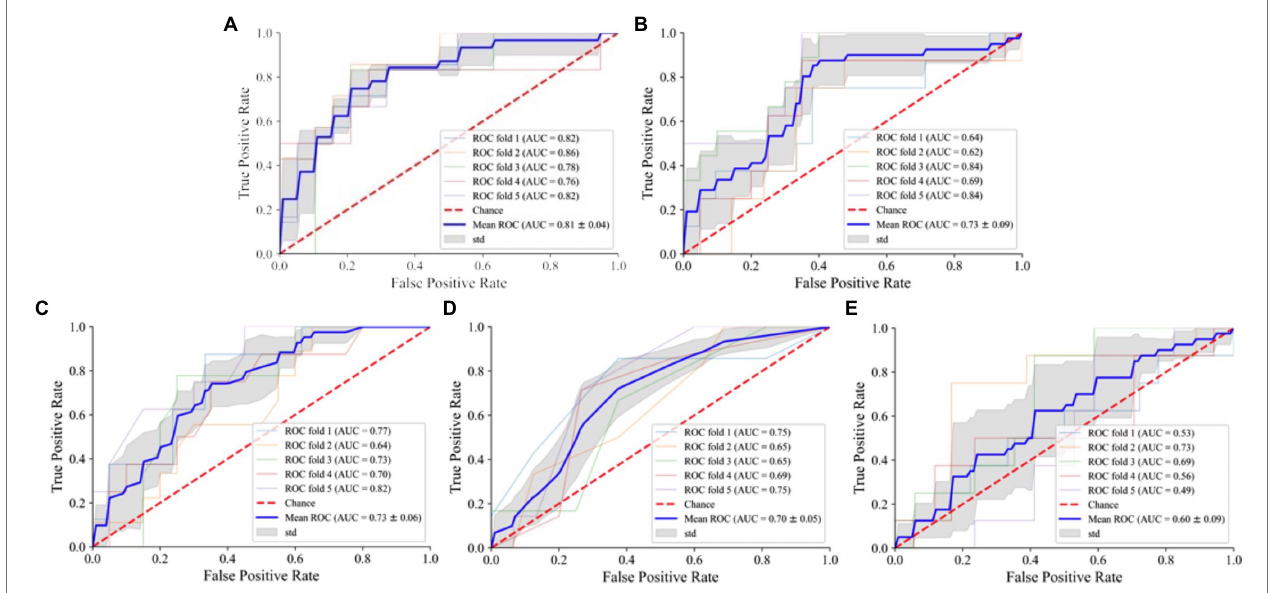
FIGURE 4 | ROC curve of different models of women’s speed skating medals. (A) SVM: support vector machine; (B) RF: random forest; (C) LR: logistic regression; (D) KNN: K-nearest neighbor; (E) NB: naive Bayes.